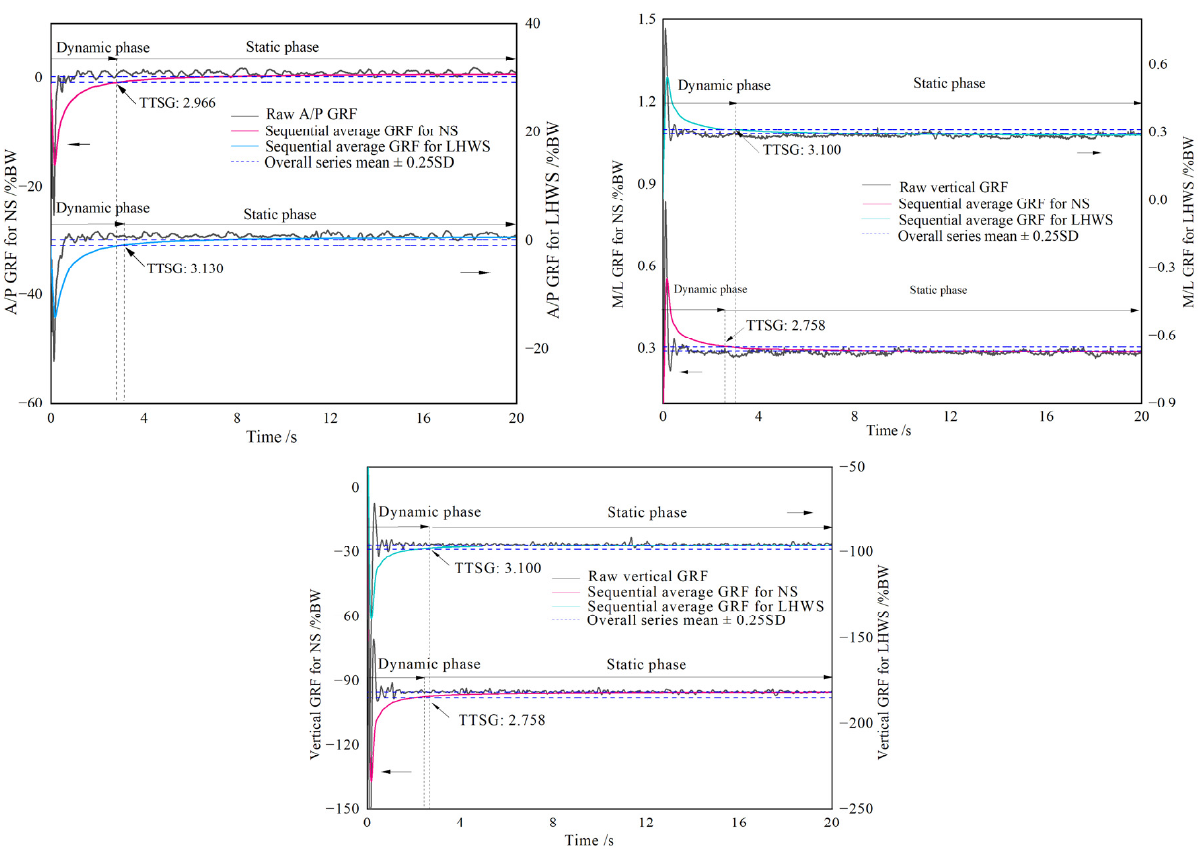
Figure 3. TTSG in three directions for single-leg jump trials for NS and LHWS. GRF: ground reaction force, TTSG: time to stabilization for ground reaction forces, TTSC: time to stabilization for the center of mass, NS: new shoes, LHWS: worn shoes with lateral attrition heel; SD: standard deviation, A/P: anteroposterior, M/L: mediolateral, BW: body weight.